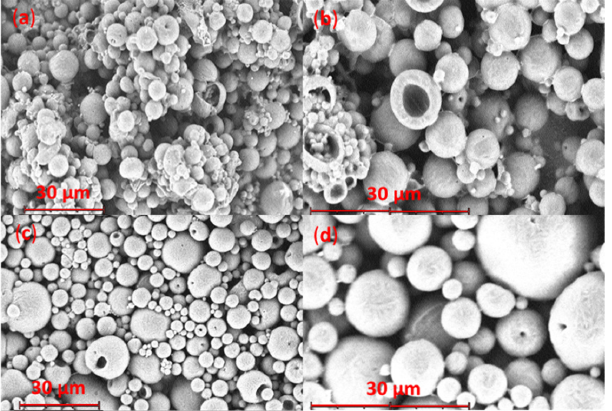
Figure 6. SEM micrographs of RB-PCL microspheres, obtained at different magnifications: ( a ) aRB-PCL at 2350×; ( b ) aRB-PCL at 4700×; ( c ) bRB-PCL 2350×; ( d ) bRB-PCL 6700×.